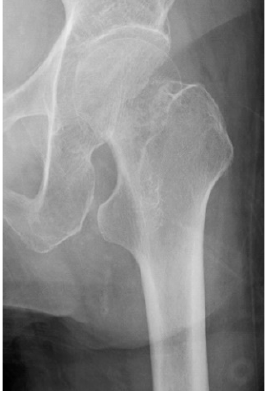
Figure 4. Image of measurement difficulties by valgus tilt measurement.